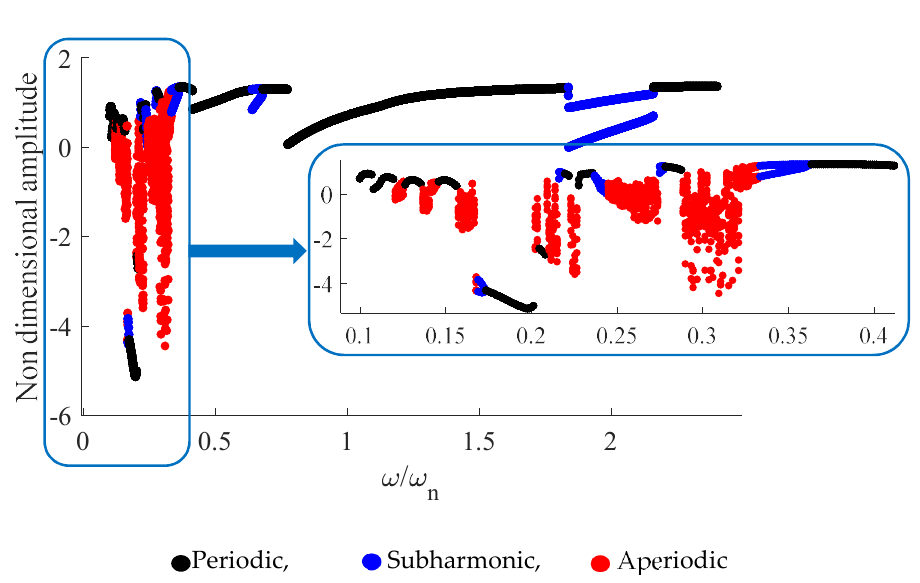
Figure 5. Bifurcation diagram based on forward simulation, case 1.